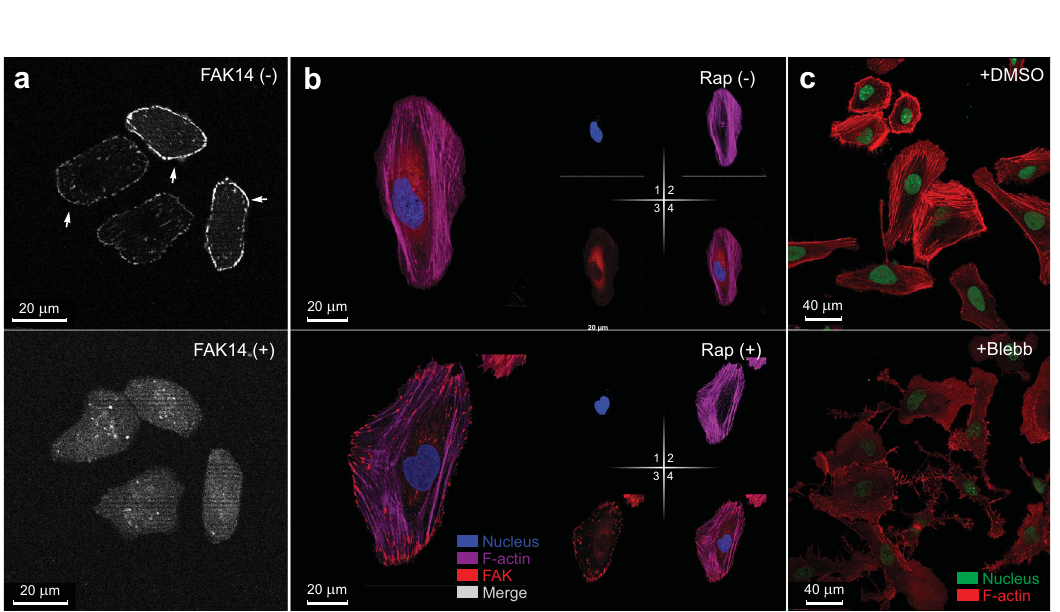
Fig. 4 FAK inhibition blocks effects of rapamycin on Ch -FAK-expressing FAK − / − fi broblasts. a Images of rapamycin-treated Ch -FAK-expressing FAK − / − fi broblasts treated with control (DMSO) and FAK inhibitor 14. Top panel shows the Ch -FAK-activated FAK − / − cells treated with control. Arrows indicate focal adhesions. Bottom panel shows same set of cells treated with FAK inhibitor 14. Scale bar, 20 μ m. b Images of Ch- FAK-expressing FAK − / − fi broblasts without (top) and with (bottom) rapamycin stained with phalloidin to reveal stress fi bers (magenta). Large focal adhesions formed by the activation of Ch - FAK are visible as red clusters (mCherry fl uorescence) at the ends of stress fi bers in bottom panel. Nuclei were stained with Hoechst (blue). Individual channels are shown to the right of the merged images. Scale bar, 20 μ m. c Images of rapamycin-treated Ch -FAK-expressing FAK − / − fi broblasts treated with control (DMSO) (top) or blebbistatin (bottom). Red indicates phalloidin stained stress fi bers and green indicates Hoechst-stained nucleus. Scale bar, 40 μ